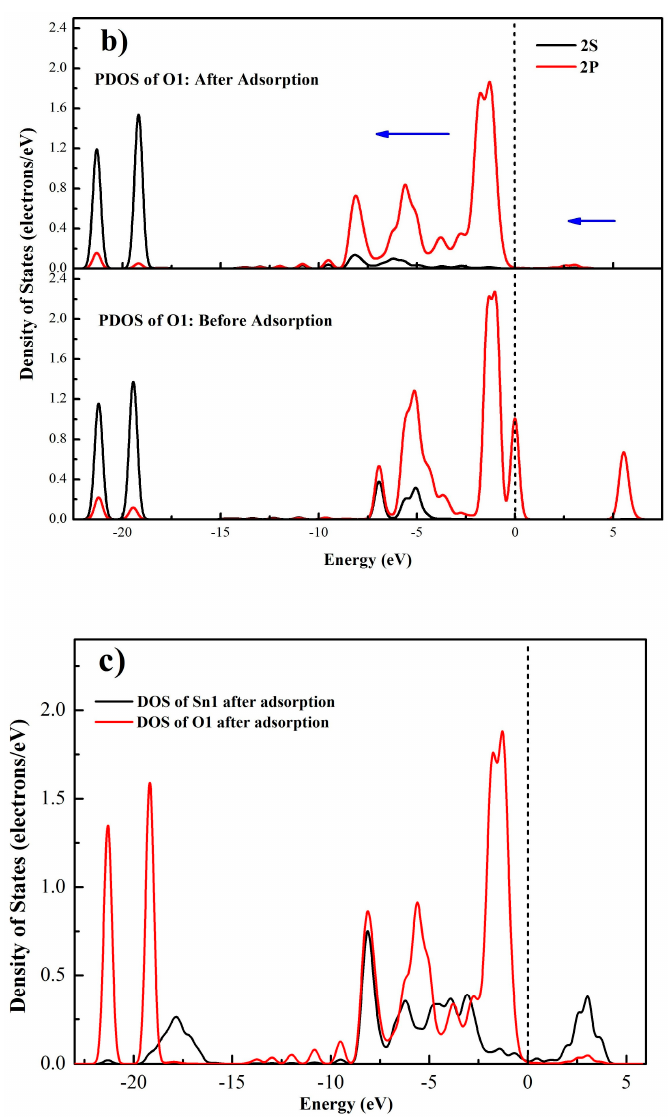
Figure 10. Partial density of states (PDOS) of Sn1 ( a ) and O1 ( b ) atoms before and after adsorption, density of states of Sn1 and O1 atoms after adsorption ( c ), (the blue arrows illustrates the peak shift directions).